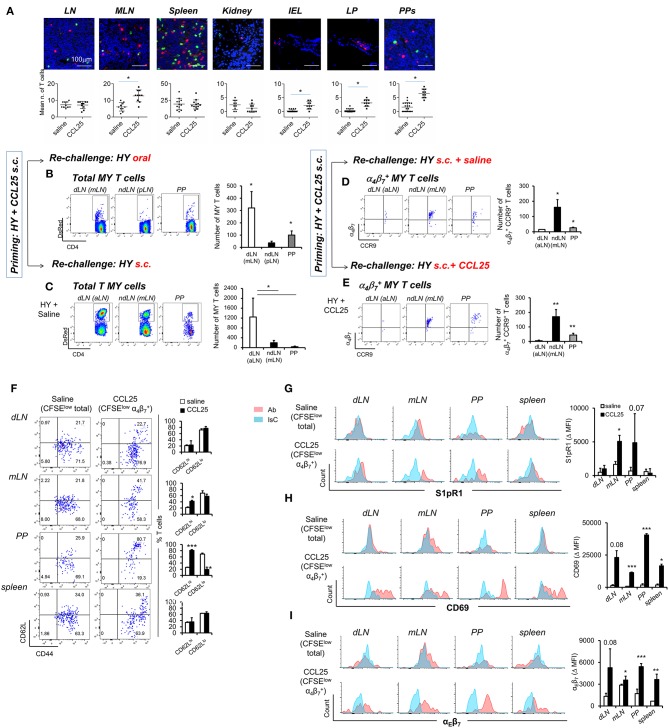
CCL25-induced α4β7+ CD4+ T cells localize to the GI tract and do not recirculate. T cells isolated from dLN of Marilyn-rag2−/− mice immunized s.c. with male splenocytes either in the presence or absence (saline) of the chemokine CCL25 (0.06 mg/kg) were labeled with the red-fluorescence cell-linker PKH26 (2 μM) and injected i.v. (107/mouse) into syngeneic C57BL/6 male recipients. Localization of labeled T cells in the indicated tissues was analyzed 24 h later by wide field fluorescence microscopy. Representative images and the mean number of labeled cells detected in at least three samples from each recipient in three independent experiments (n = 3) are shown in (A). Scale bar: 300 μm. CD44hi DsRED-expressing Marilyn T cells were isolated by cell sorting from the dLN (axillary) and spleen of mice immunized s.c. 7 days earlier in the presence of CCL25. (B,C) T cells were subsequently transferred into naïve female C57BL/6 recipients, which received an antigen challenge in saline solution orally (B) or s.c. (C) a week later. The presence of DsRED Marilyn (MY) T cells in the dLNs, ndLN and PPs was assessed 4 days after antigenic challenge. MY T cells were further identified by the expression of Vβ6. The mean number of T cells from at least three recipients (±SD) is shown on the right-hand-side of representative dot-plots (*p < 0.05). (D,E) Recipients of T cells from mice primed s.c. in the presence of CCL25 were also antigen-re challenged s.c. in the absence or presence of CCL25. To discriminate the α4β7+ and CCR9+ cells within the MY CD4+ T cell population gating was set on DsRED and CD4. DsRED Marilyn (MY) T cells in the dLNs, ndLN, and PPs were analyzed 4 days after antigenic challenge. The mean number of T cells from at least three recipients (±SD) is shown on the right-hand-side of representative dot-plots (*p < 0.05, **p < 0.01). (F–I) CD4+ T cells from Marilyn-rag2−/− mice (107/mouse) were labeled with CFSE (4 μM) and injected intravenously into female syngeneic recipients. Recipient mice were immunized 24 h later by s.c. administration of 5 × 106 male-derived splenocytes re-suspended in saline solution or in the presence of CCL25 (0.06 mg/kg). One week later, T cells were separately harvested from draining LN (axillary, dLN), mesenteric LNs (mLNs) and Peyer's Patches (PPs) and spleen. Expression of the indicated molecules was assessed by flow cytometry. Comparison are made on Marilyn T cells identified by gating on the total divided CD4+Vβ6+CFSElow T cell population from mice immunized in the presence of saline, and on the CD4+Vβ6+CFSElowα4β7high T cell population from mice immunized in the presence of CCL25. CD4+Vβ6+CFSElowα4β7high T cells were retrieved in negligible numbers from mice immunized in the presence of saline, making it unfeasible to analyze this population. In panel (F), representative dot plots are sided by graphs representing the mean % of T cells detected in at least three animals, In panels (G–I), representative histograms of CCL25-induced or control T cells are shown. The blue histograms depict staining with an isotype-matched control antibody (IsC). In each panel, the column graphs display the mean delta MFI (experimental MFI—IsC MFI) detected in T cells from three animals (±SD, *p < 0.05, **p < 0.01, ***p < 0.001) (N = 2).